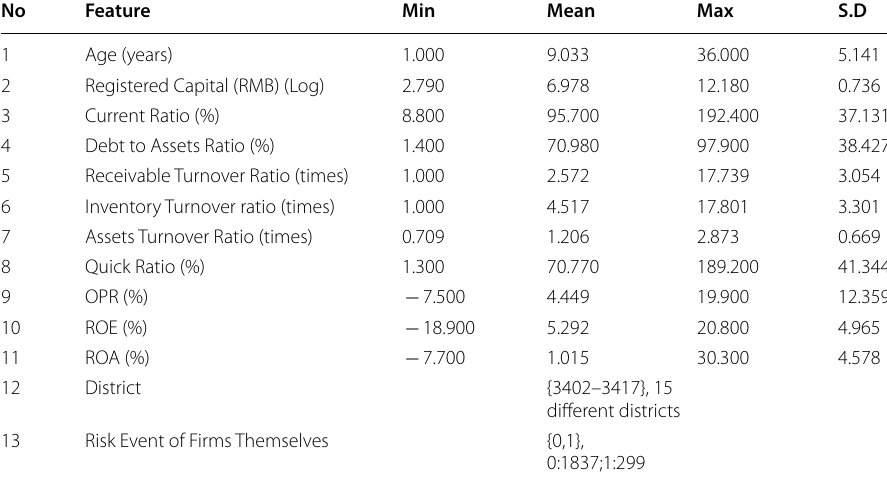
Table 8 Descriptive statistics of basic features on manufacturing SMEs dataset